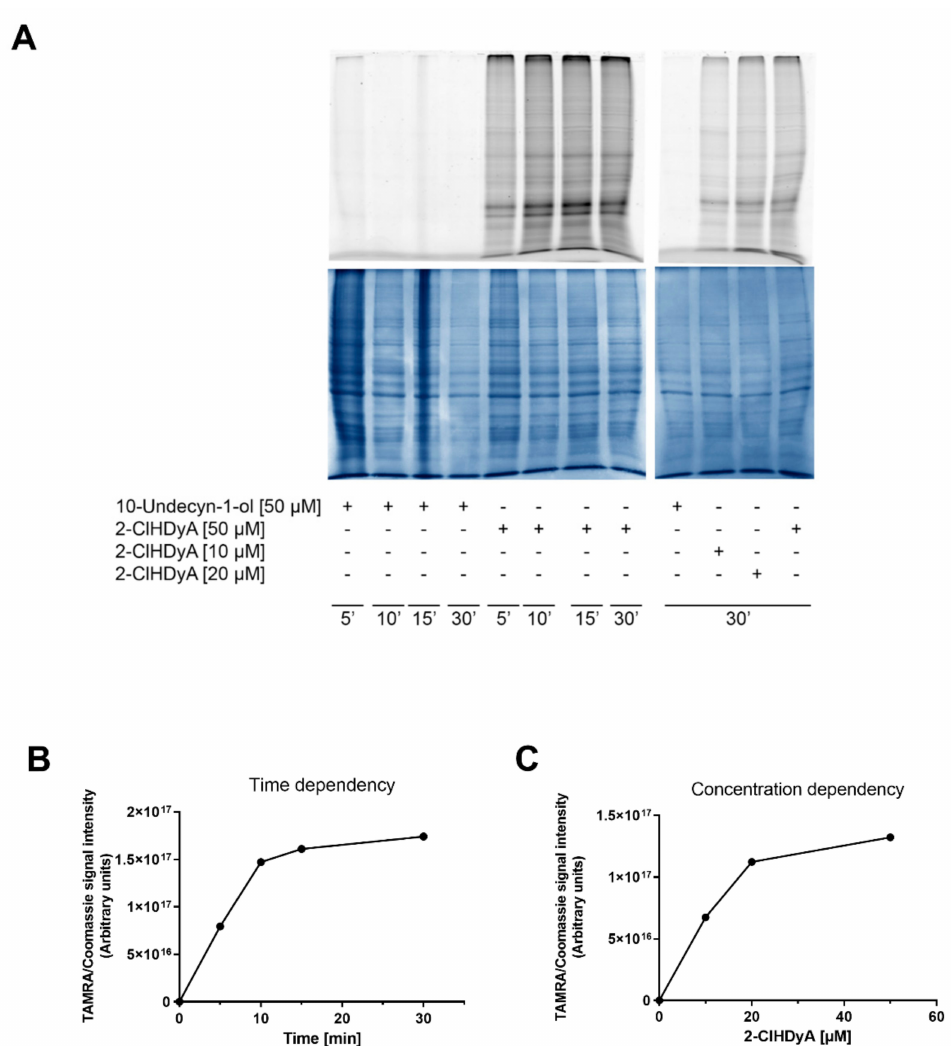
Figure 5. Adduct formation of 2-ClHDyA with cardiac proteins. ( A ) HL-1 cells were incubated in the absence (‘-‘) or presence (‘ + ’) of 50 µ M 2-ClHDyA for the indicated time points (left panel) or with 10, 20, and 50 µ M 2-ClHDyA for 30 min (right panel). 10-Undecyn-1-ol served as a negative control. Cell lysates were subjected to click chemistry with N 3 -TAMRA, separated by SDS-PAGE, and imaged using a Typhoon 9400 scanner (upper panel). Coomassie Brilliant Blue staining was performed to verify equal protein loading (lower panel). ( B ) Time- and ( C ) concentration-dependent increase in fluorescence intensities normalized to overall protein intensity / lane from the gels shown in ( A ). One representative experiment is